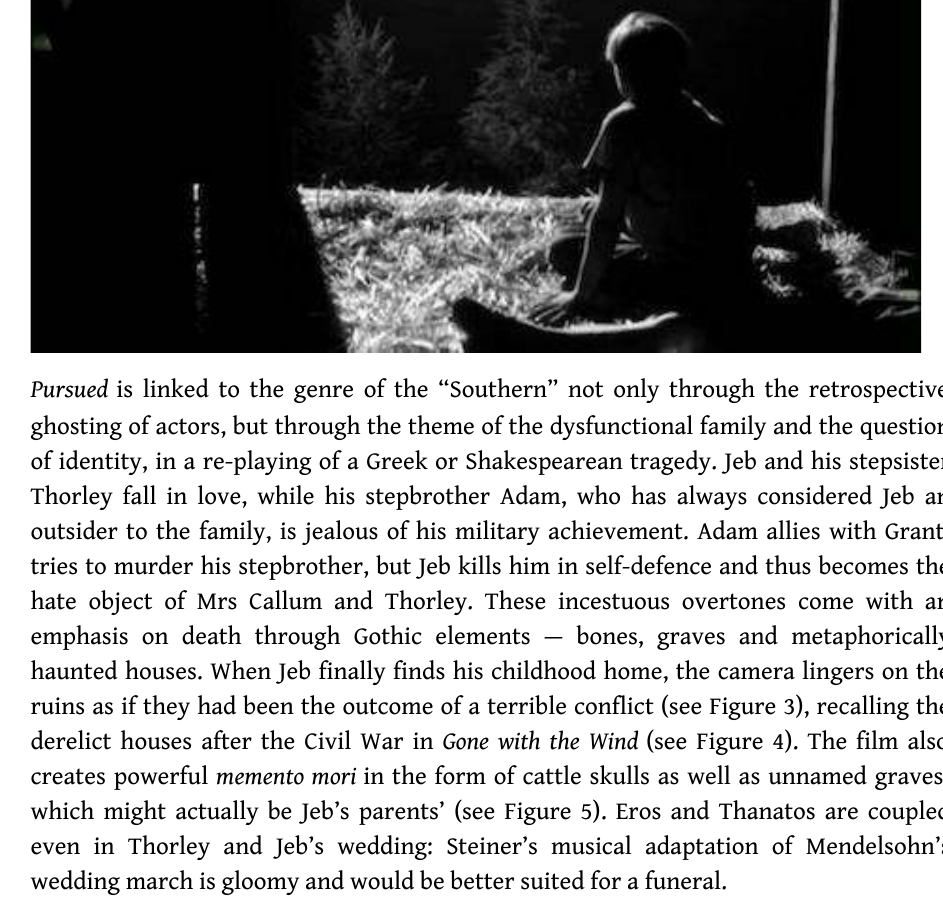
Raoul Walsh, between the Western and the Southern: Pursued (1947), Silver